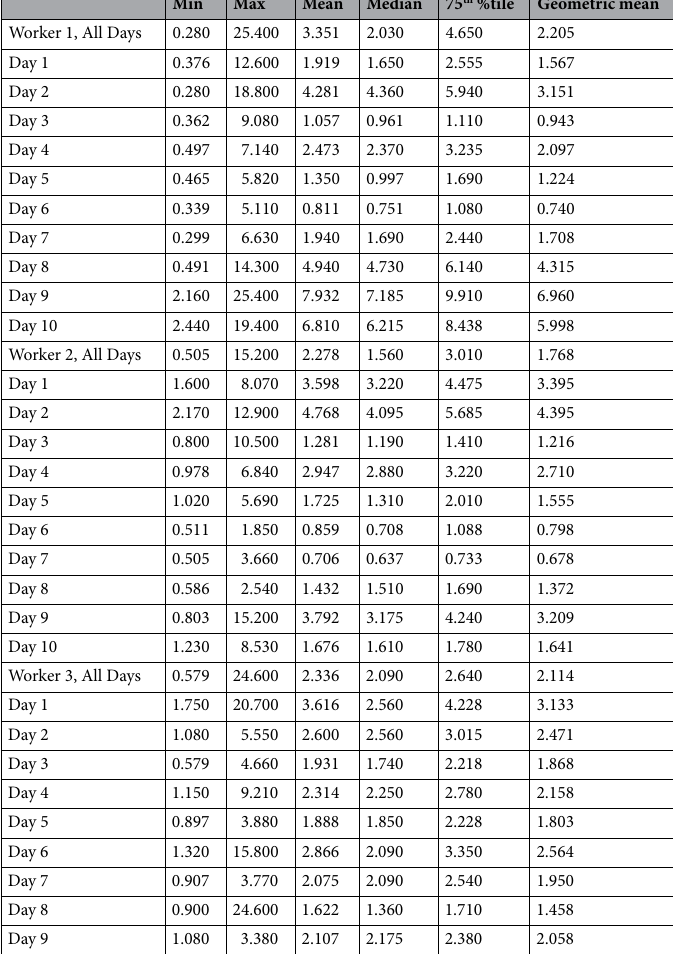
Table 1. Respirable particulate matter mass concentrations from daily personal samples in three workers in mg/m 3 .